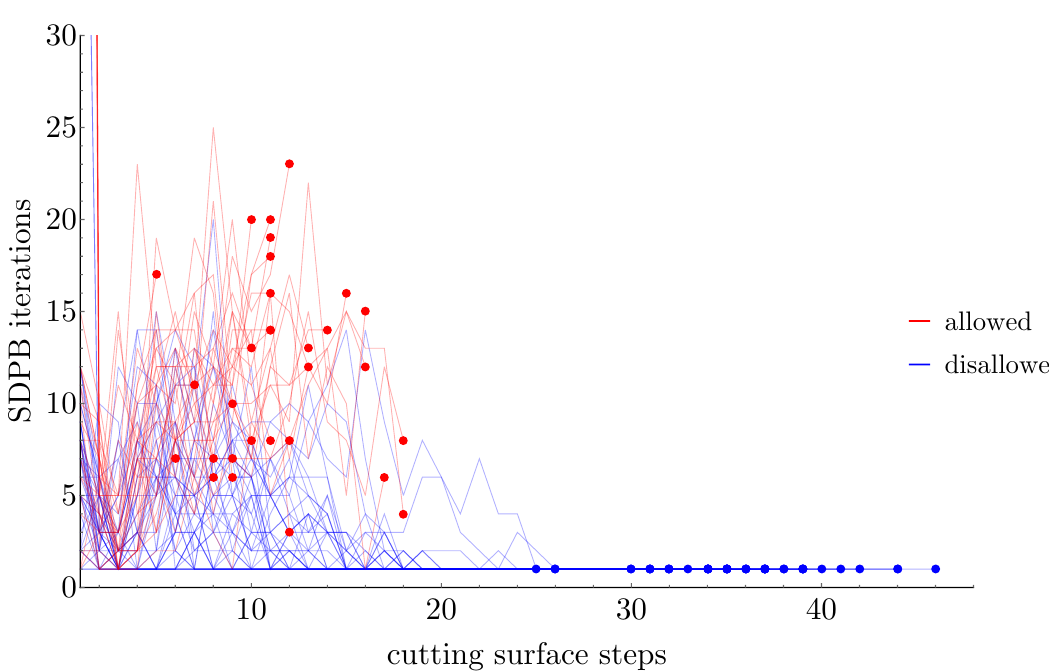
Figure 5 . Number of iterations of SDPB in each step of the cutting surface algorithm, for our computation of the O(2) model island with (cid:3) = 43. Hot-starting drastically reduces the number of iterations throughout the computation. The blue paths represent OPE scans that eventually terminate by ruling out a point in dimension space. The red paths represent scans that eventually terminate by (cid:12)nding an allowed (primal) point. We mark the end of each path with a dot. At the beginning of the computation, a small number of points require (cid:24) 200 SDPB iterations during the (cid:12)rst step of the cutting surface algorithm. Once the checkpoints from those SDPB runs have been generated, hot-starting ensures that most subsequent runs take . 20 SDPB iterations. The (cid:12)rst 10{20 steps of the cutting surface algorithm typically require 1{15 SDPB iterations each. If the point is allowed, the algorithm typically (cid:12)nds it within 20 steps. If the point is disallowed, subsequent steps of the cutting surface algorithm take fewer iterations, with the last several steps requiring 1 iteration